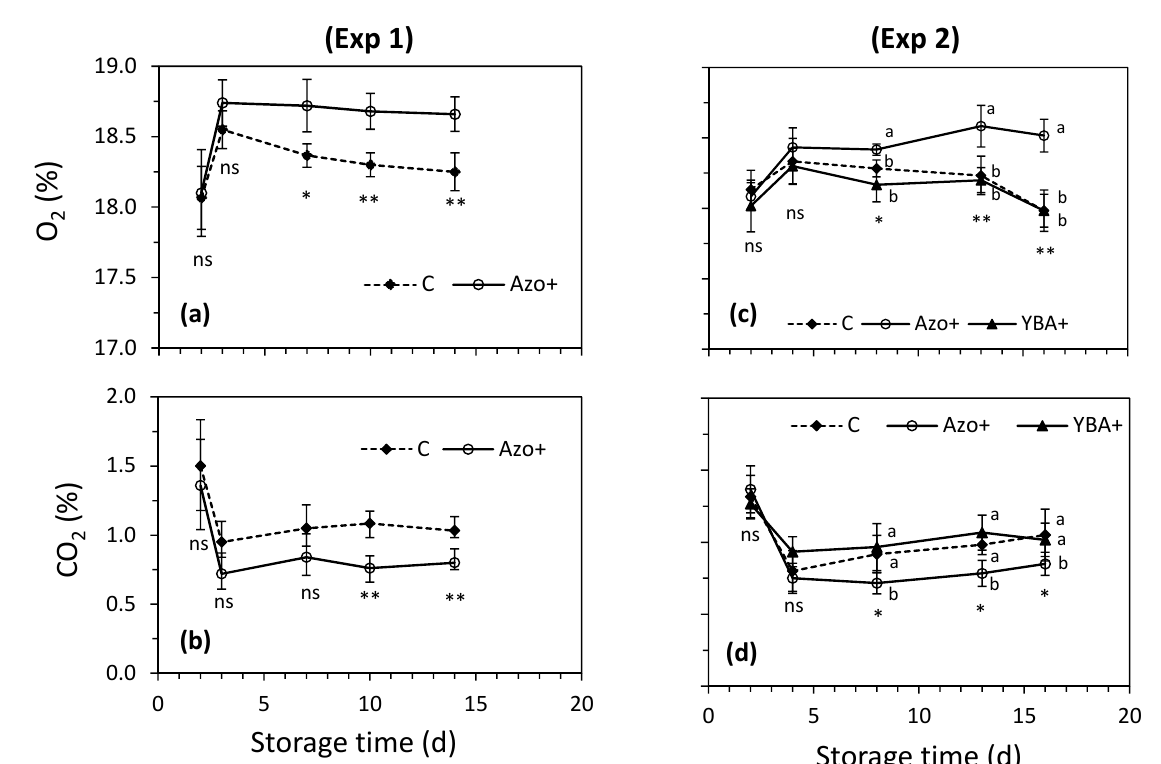
Figure 1. And carbon dioxide (CO 2 ) concentration trend inside the packages during the storage of the wild rocket treated with Azoxystrobin (Azo+) at preharvest in Exp 1 ( a , b ), and with Azoxystrobin or an algae-based biostimulant (YBA+) in Exp 2 ( c , d ), and of that relating to the untreated control (C). Vertical bars indicate SD (n =3). ns, * and ** indicate F test not significant, significant at P ≤ 0.05 and significant at P ≤ 0.01, respectively. Separation of mean within the days from the start of storage by SNK test ( P = 0.05). Different lower case letter denotes significant differences. From the analysis of the qualitative attributes, a positive effect of Azoxystrobin on freshness indicators (VA, Od, YI) is generally highlighted. The VA and Od progressively worsen during storage in both treatments, but with less intensity in Azo+ (Figure 2a,b).